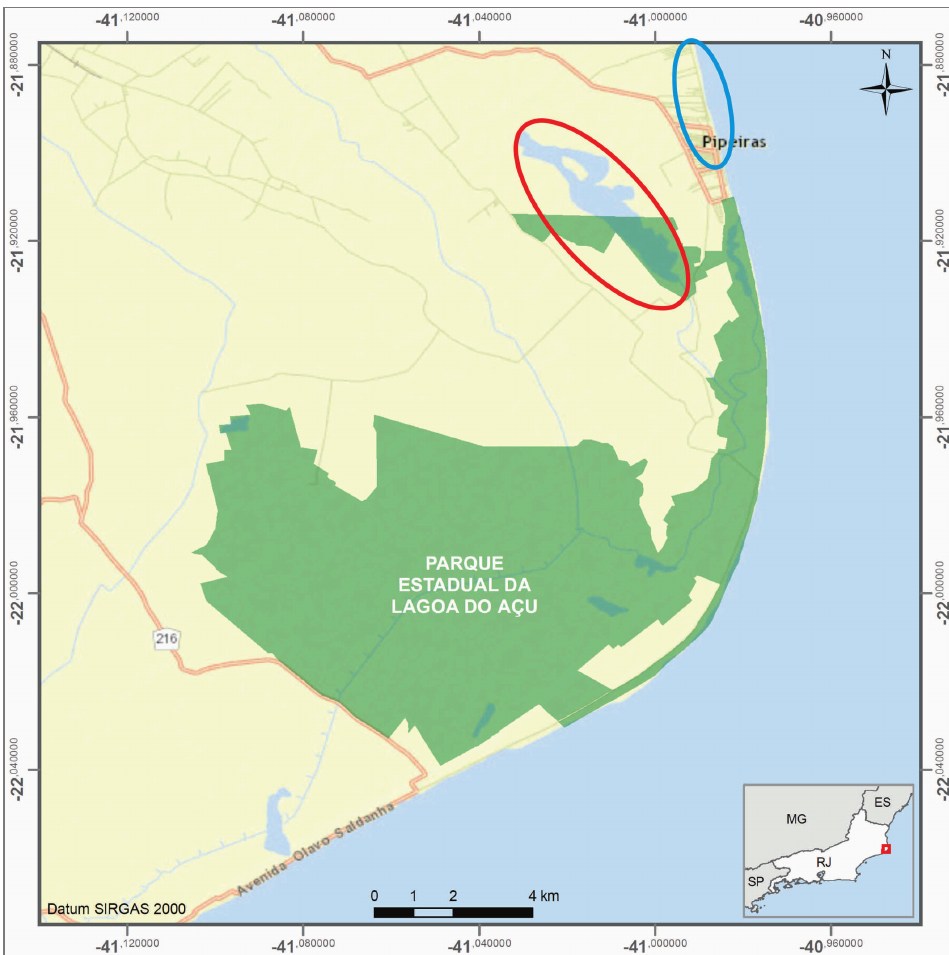
Figure 2 - Map with the location of the Lagoa do Açu State Park. Area encircled in red - Lagoa Salgada partially protected. Area encircled in blue – part of the area of the Açu Port.